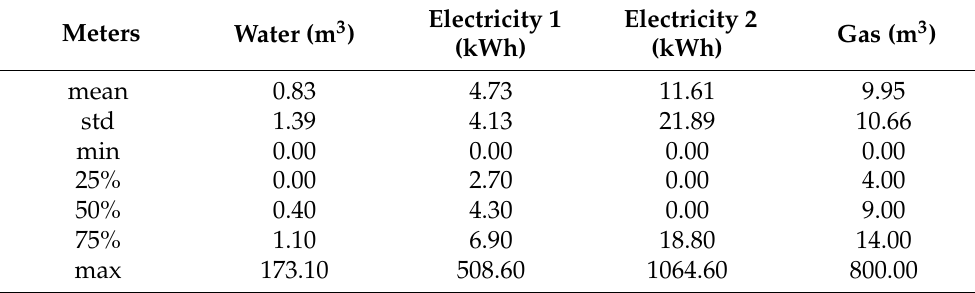
Table 1. Statistical description of the meters’ readings in the analysis.